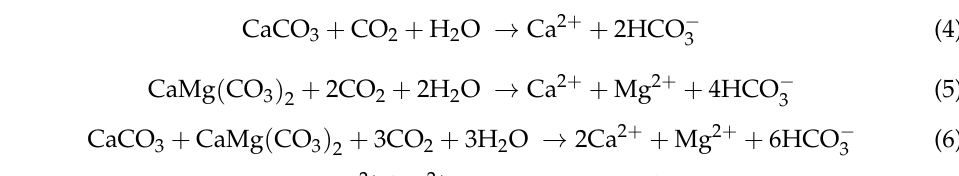
Figure 8. Relationship of Cl − vs. K + , Na + , SO 2− groundwater ( b ).